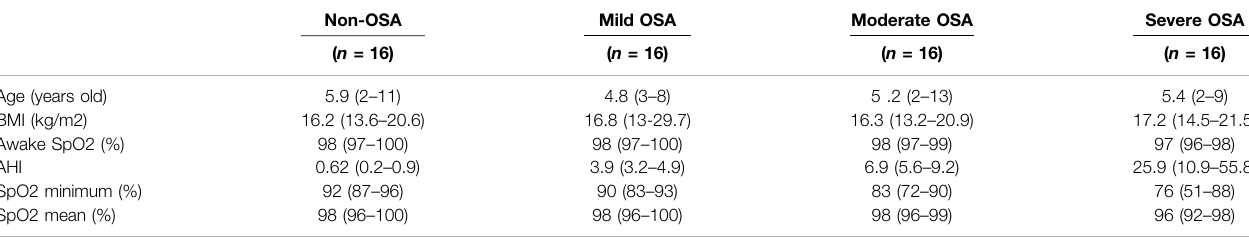
TABLE 1 | Clinical characteristics of all the recruited